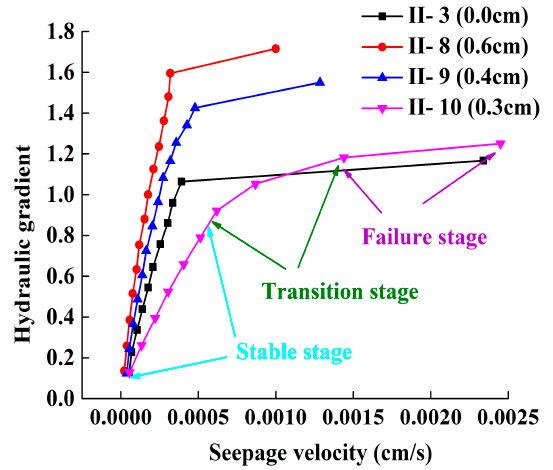
Figure 8. Hydraulic gradient–seepage velocity curves under different roughnesses.